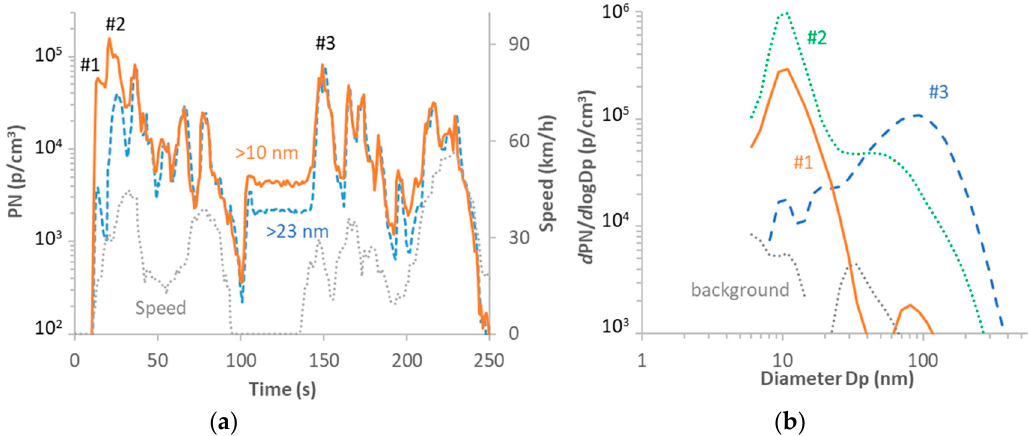
Figure 4. Nonvolatile particle number (PN) emissions during a cold start: ( a ) nonvolatile PN > 23 nm and > 10 nm and ( b ) size distributions of nonvolatile PN during the three points given in panel (a). All instruments measuring from the dilution tunnel.